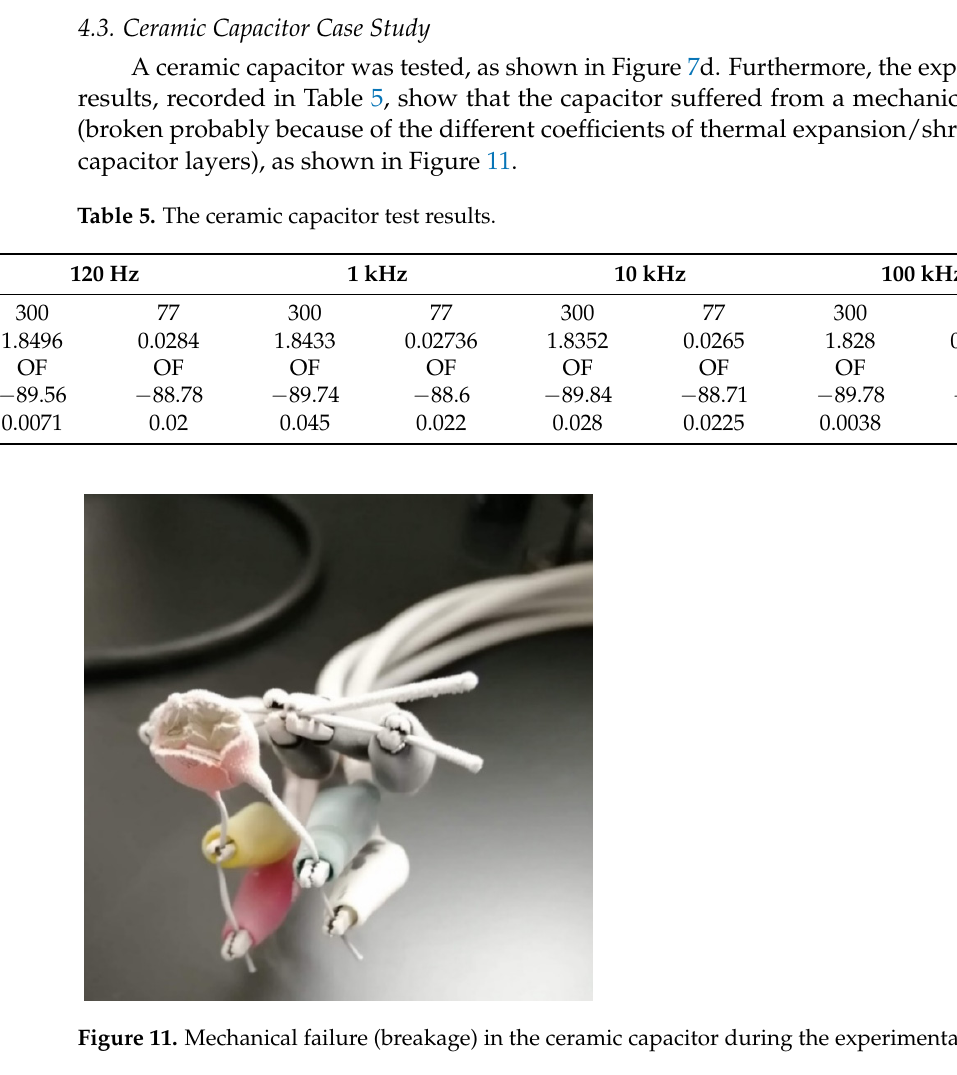
Figure 12. Comparative analysis of the capacitance values for specified types of capacitors under different frequencies at room and cryogenic temperatures. 5. Conclusions The characteristics of switching devices with different technologies used in power inverters employed in cryogenically-cooled electric aircraft applications were investigated in this study. The characterization tests conducted on the switching devices at cryogenic temperature revealed the unsuitability of SiC MOS switches in operations at cryogenic temperatures due to excessive increases in ON resistance compared to Si SJ-MOS and GaN HEMT switches. Moreover, the GaN HEMT switches demonstrated superior performance in cryogenic temperature operations in terms of breakdown voltage and ON resistance. Furthermore, the performances of three commercial types of capacitors (electrolytic, met- alized film, and ceramic) were investigated experimentally at cryogenic temperatures. Such investigations demonstrated a stable performance of metalized film capacitors in contrast to the unsatisfactory operation of electrolytic and ceramic capacitors at a cryo- genic temperature, in which the latter suffers from an unreliable operation and mechani- cal failure. Considering the above-addressed findings, new capacitor-less topologies should be developed for operation at cryogenic temperatures.